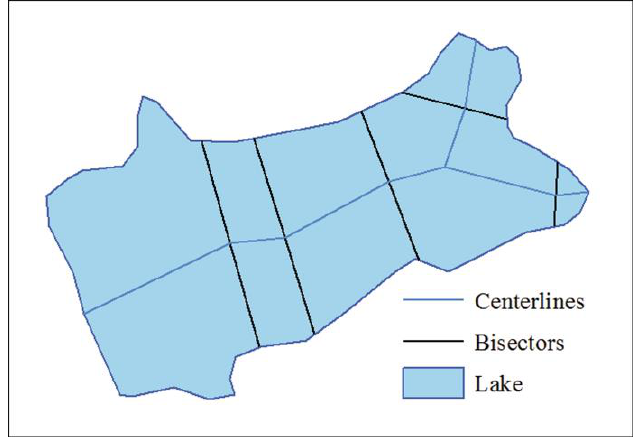
Figure 5. Bisectors at the artificial path vertices of a linear elongated stream-like